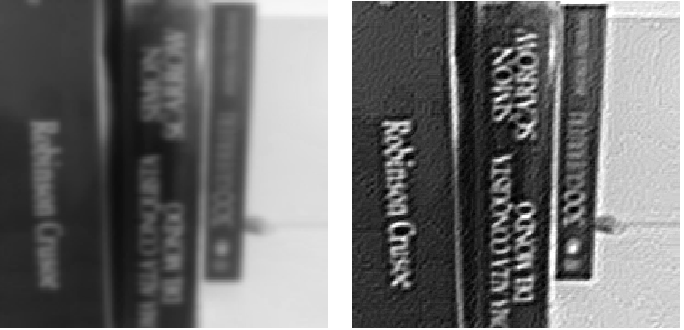
Figure 15. Result of deblurring on a comprehensive image set (Image 11_IM): ( Left ) input image; and ( Right ) output of the ICA neural